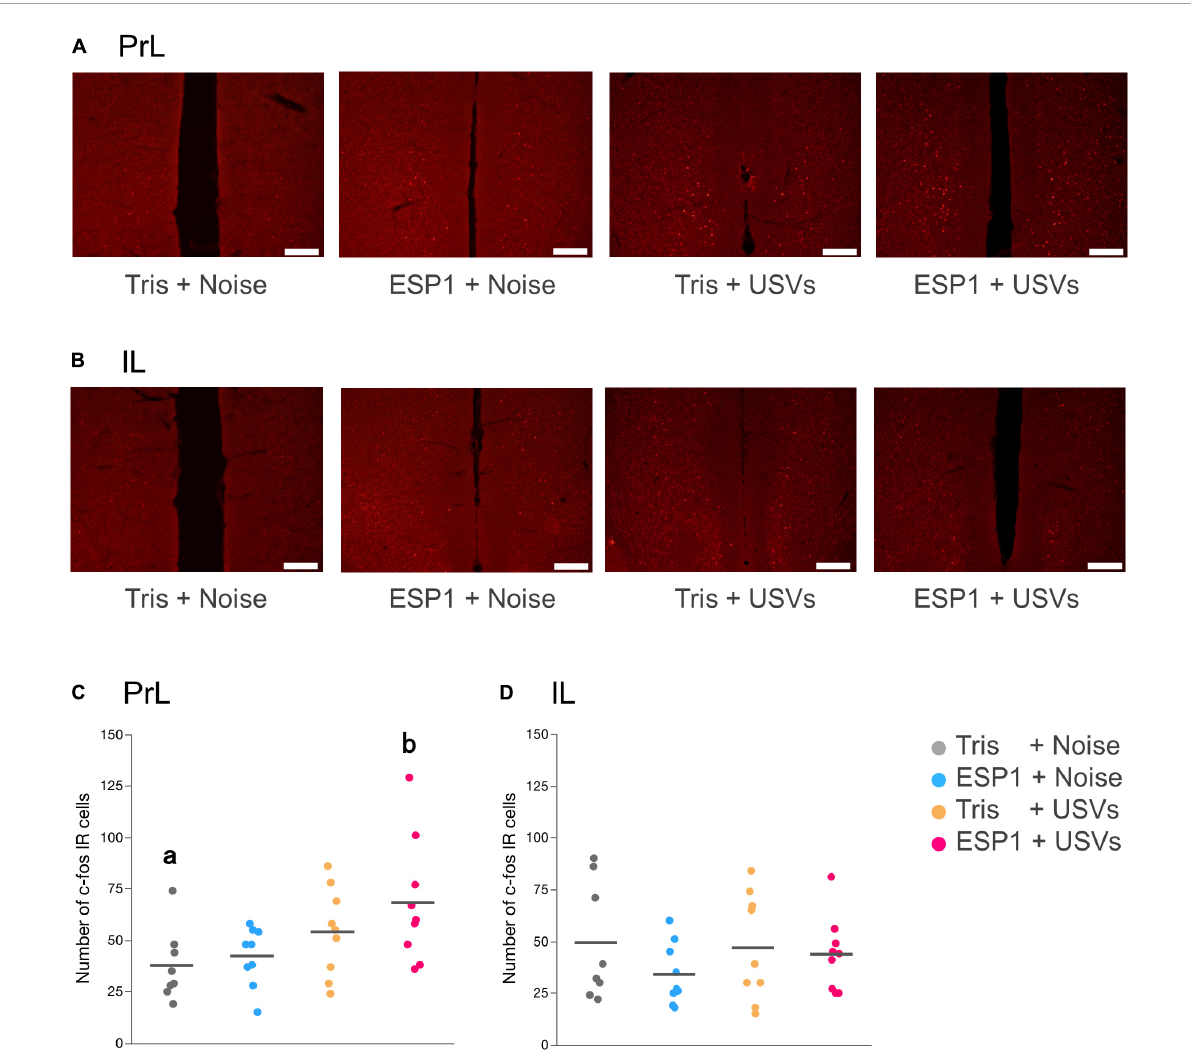
FIGURE6 Presentation of ultrasonic vocalizations (USVs) activates PrL neurons. (A,B) Representative fluorescent images of c-fos positive cells in PrL and IL. Positive cell is shown in red. Scale bar indicates 0.2 mm. (C,D) Number of c-fos positive cells for PrL and IL in the 2 × 2 factorial experimental design. Dots represent individual data. Colors of dots indicate experimental groups. Horizontal lines represent mean values. Different letters indicate significant differences ( p < 0.05, Tukey HSD